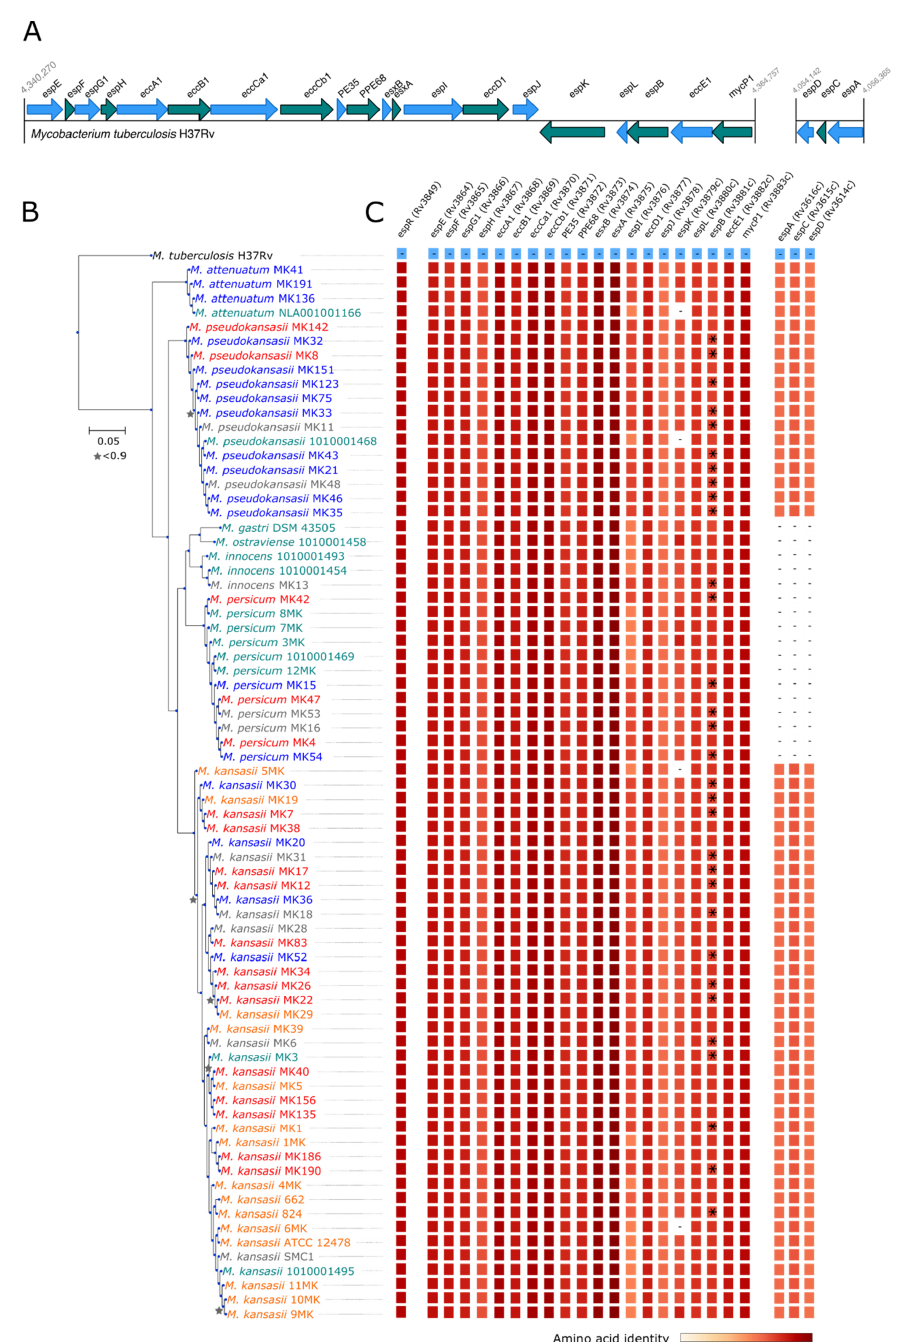
Figure 1. Maximum-likelihood core-genome phylogeny and conservation of the Type-VII secretion system-associated ESX-1 and espABC loci among members of the M. kansasii complex ( A ) ESX-1 and EspACD loci of M. tuberculosis H37Rv. Ecc, ESX-1 conserved components; Esp, ESX-1 secreted protein. EsxA, ESAT-6; EsxB, CFP-10. EspACD locus is required for the secretion and function of EsxA and EsxB. ( B ) Maximum-likelihood phylogeny based on the concatenated amino acid alignments of single-copy orthologous proteins forming the core genome. Node supports based on the Shimodaira-Hasegawa (SH) test are indicated with a star when below 0.9. The scale bar represents the number of amino acid substitutions per site alongside the branches. Species pathogenicity is color-coded according to the results reported in Table 1. Red = 1 = pathogenic, Orange = 2 = probably pathogenic, Grey = 3 = unknown, Green = 4 = probably non-pathogenic, Blue = 5 = non-pathogenic. ( C ) Conservation of the type-VII secretion system ESX-1 locus and EspACD in members of the M. kansasii complex. EspACD was absent from all isolates of M. gastri , M. ostraviense , M. innocens and M. persicum . The amino acid identity with the reference M. tuberculosis sequence (in blue) is indicated. Stars in the column of espB homologs indicate that the gene was split due to assembly